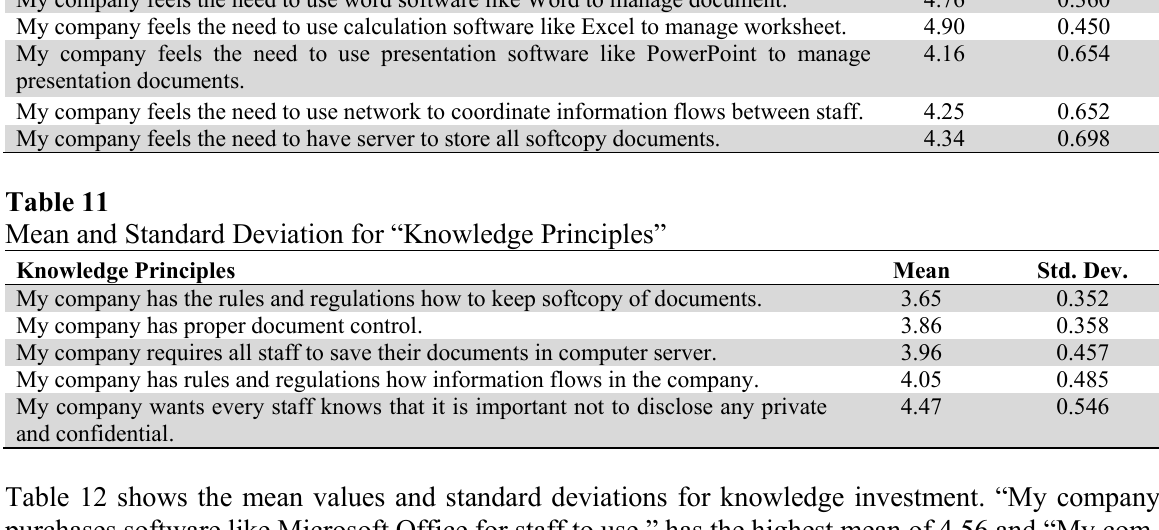
Mean and Standard Deviation for “Knowledge Infrastructure” Knowledge Infrastructure